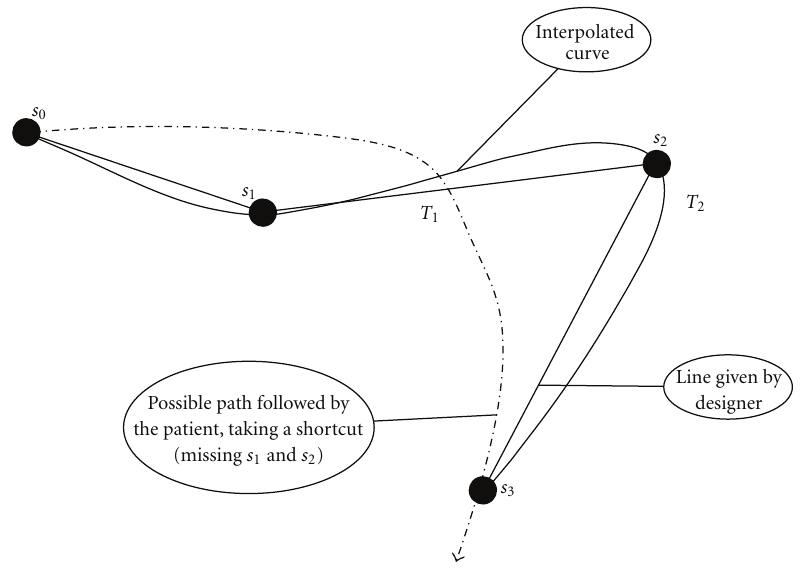
Figure 2: Illustration of a possible “shortcut a user can